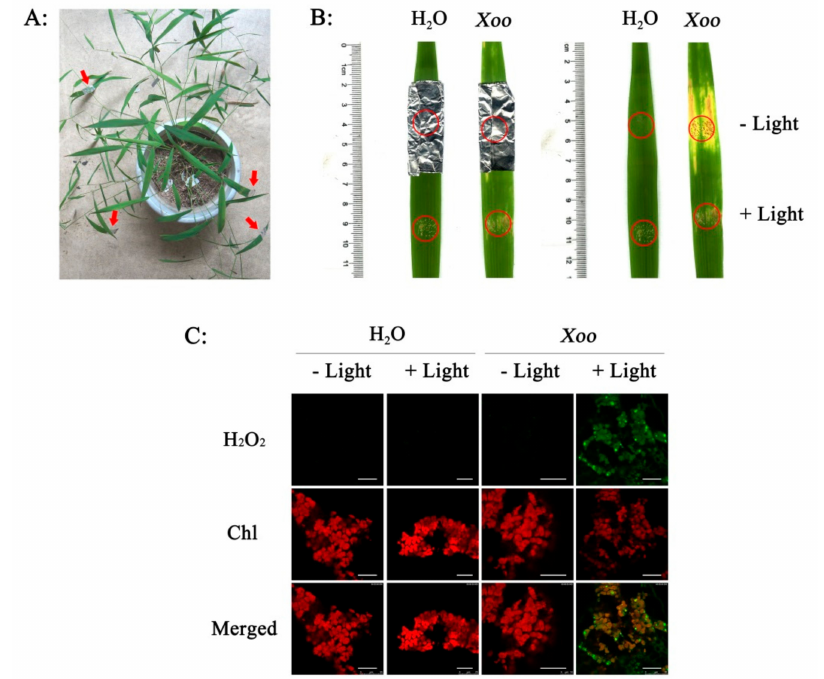
Figure 6. Resistance to Xoo and H 2 O 2 accumulation in chloroplasts were dependent on light in O. meyeriana . ( A ) Shading treatment with aluminum foil to the leaves of O. meyeriana . ( B ) E ff ect of light on the lesion length caused by Xoo infection. ( C ) E ff ect of light on the subcellular localization of H 2 O 2 . Chl: chloroplast. Scale bars = 20 µ